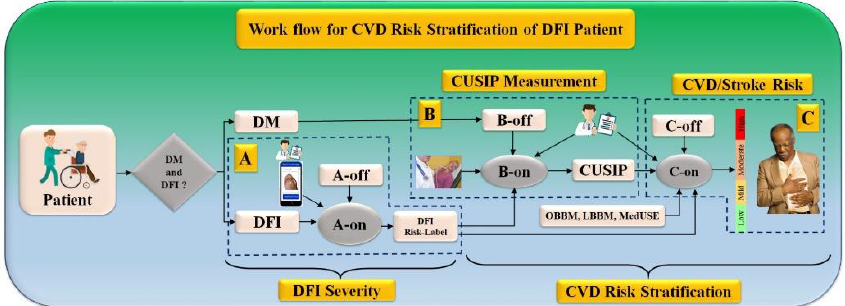
Figure 14. The overall architecture of CVD screening on DM and DFI patients. A-on : Online DL-based FDI severity system, A-off : Offline DL-based FDI severity system, B-on : Online DL-based Carotid wall quantification system, B-off : Offline DL-based Carotid wall quantification system, C-on : Online ML-based CVD Risk Assessment system, C-off : Offline ML-based CVD risk assessment system, DM: Diabetes Mellitus, DFI: Diabetic foot infection, CUISP: Carotid ultrasound image phenotype.